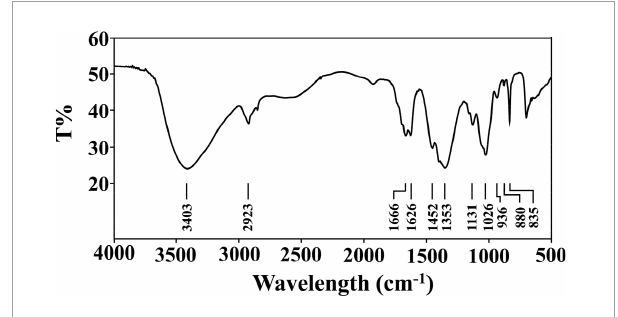
FIGURE2 FT-IR spectrum of PKP2-1 in the frequency range of 500–4,000 cm - 1